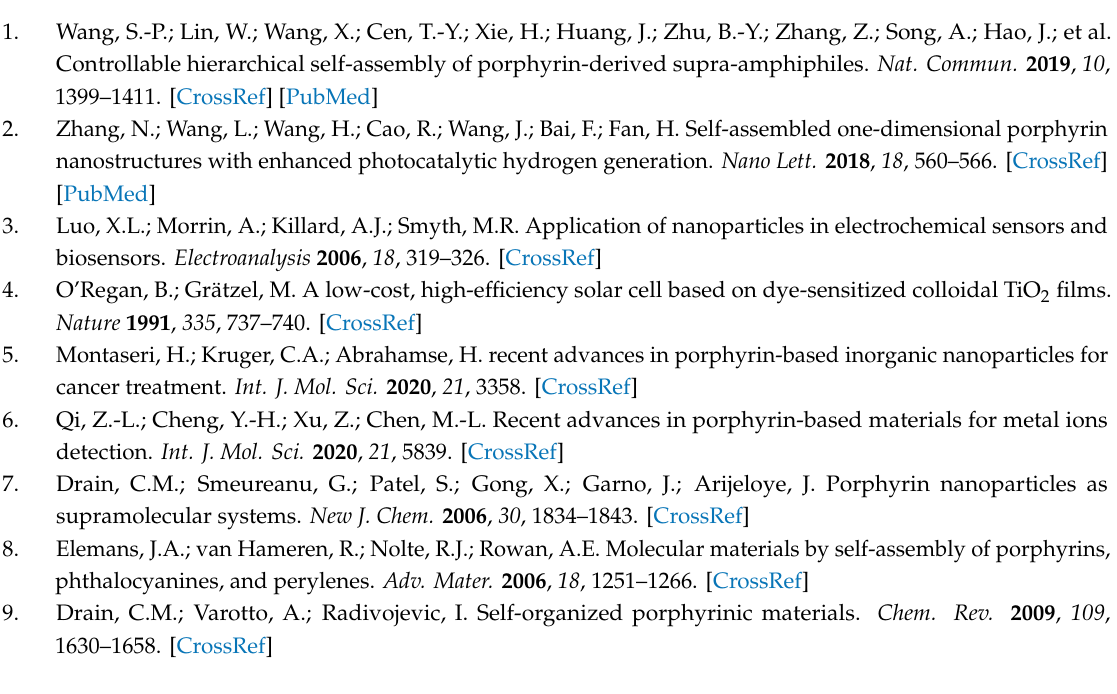
Figure S1. 1 H NMR spectrum of H 2 L 1 . Figure S2. 1 H NMR spectrum of ZnL 1 . Figure S3. 1 H NMR spectrum of H 2 L 2 . Figure S4. 1 H NMR spectrum of SnL 2 . Figure S5. 1 H NMR spectrum of triad 1 . Figure S6. 1 H NMR spectrum of triad 2 . Figure S7. 1 H NMR spectrum of triad 3 . Figure S8. 1 H NMR spectrum of triad 4 . Figure S9. ESI-MS spectrum of triad 1 . Figure S10. ESI-MS spectrum of triad 2 . Figure S11. ESI-MS spectrum of triad 3 . Figure S12. ESI-MS spectrum of triad 4 . Figure S13. SEM images for the aggregates of 1 - 4 . Figure S14. Particle analyzing data for triad 2 . Figure S15. SEM images of the aggregates of the monomers. Figure S16. Absorption spectral changes of triad 4 upon the addition of pyrrolidine. Figure S17. Fluorescence intensity changes of triad 4 upon the addition of pyrrolidine. Figure S18. SEM image for the aggregates of triad 4 upon the addition of pyrrolidine. Figure S19. Absorption spectra of MB in presence of nano fibers derived from triad 4 under visible light irradiation. Figure S20. Kinetics for the photocatalytic degradation of MB under visible light irradiation of the four triads. Figure S21. PXRD data of triad 4 before and after an experiment on the photo-degradation of MB. Figure S22. Catalytic cycles using triad 4 as a photocatalyst for the degradation of